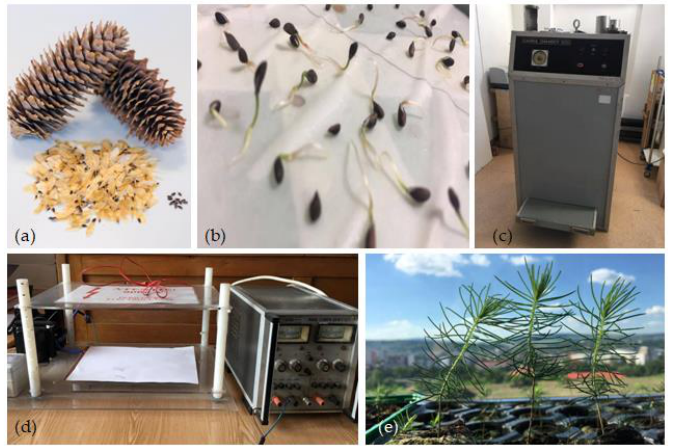
Figure 2. ( a ) Cones and spruce seeds; ( b ) sprouts; ( c ) the Gamma Chamber apparatus; ( d ) electric current generator; ( e ) spruce seedlings. current generator; ( e ) spruce